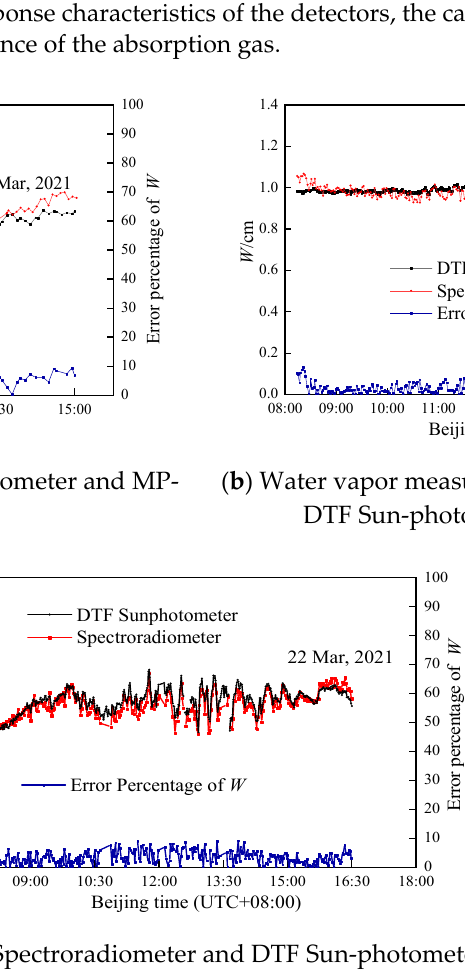
Figure 11. Graphs of the water vapor column of the spectroradiometer, DTF sun-photometer and microwave radiometer, respectively.